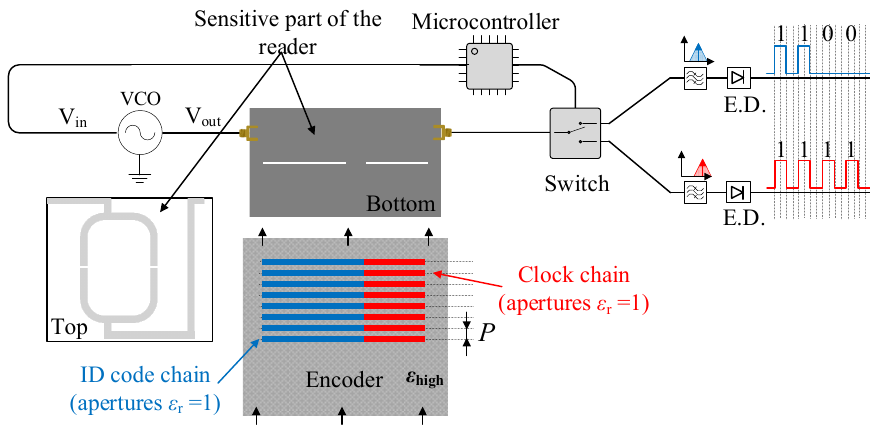
Figure 1. Sketch showing the working principle of the proposed reader/encoder system based on permittivity contrast with synchronous reading.